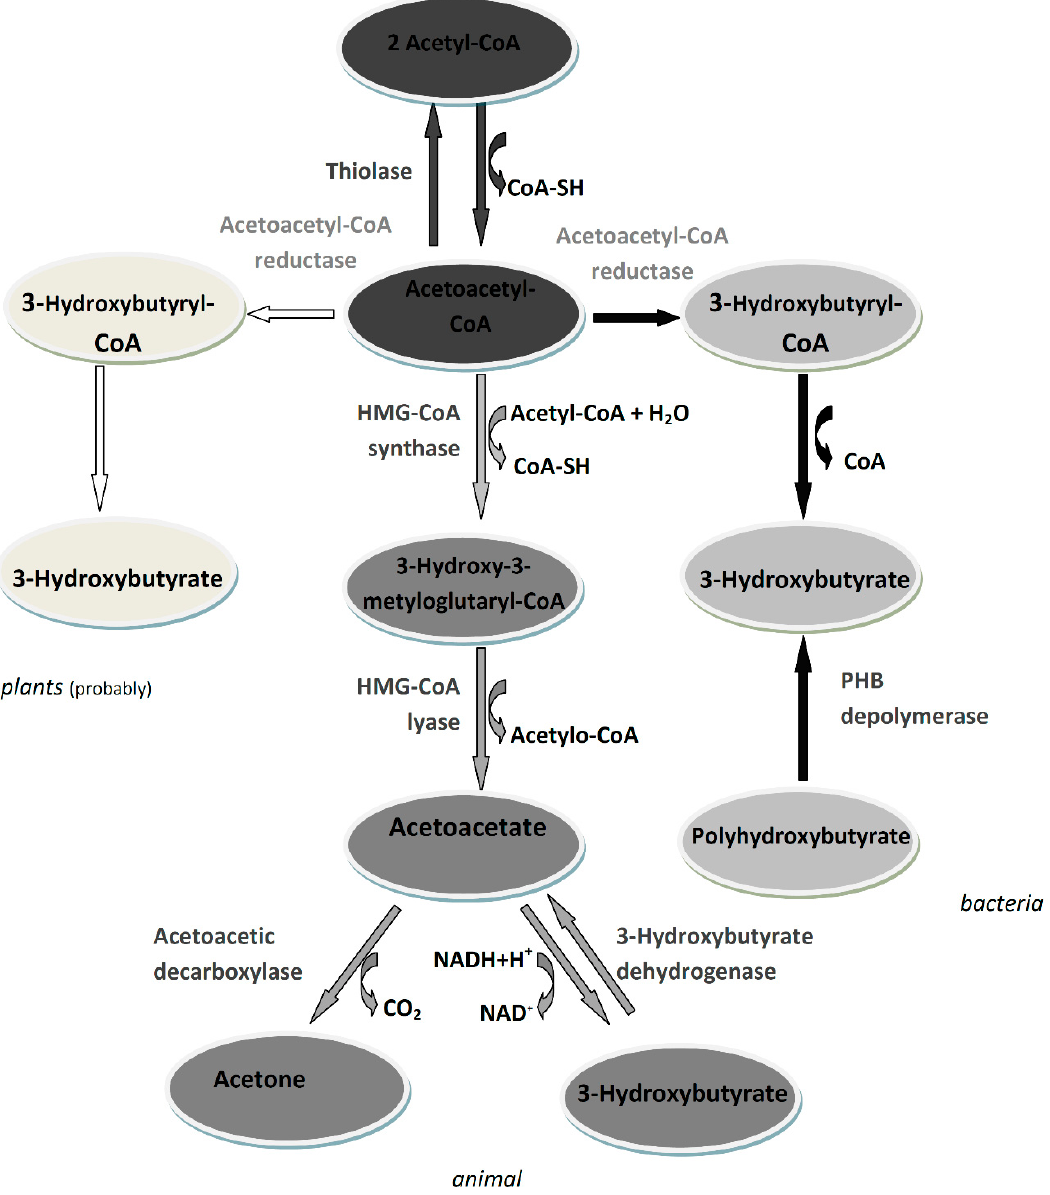
Figure 1. Metabolism of 3-hydroxybutyrate in living